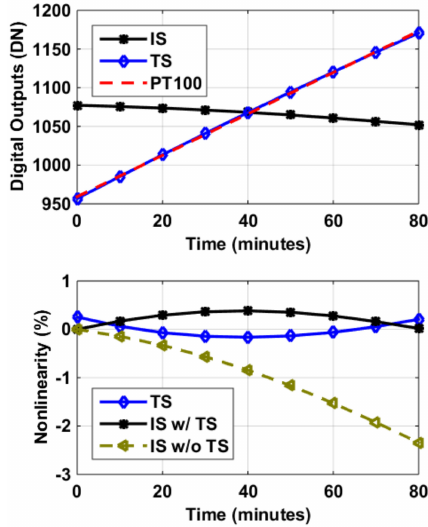
Figure 16. Top: Measured image sensor (IS) and temperature sensor (TS) outputs versus time, along with a reference temperature sensor (PT100). Bottom: when the temperature changes from 20 to 60 ◦ C gradually in a temperature chamber, nonlinearity caused by the thermal drift (IS w/o TS) was corrected with the temperature information provided by the on-chip TS (IS w/TS). The correction was done digitally and on-the-fly.